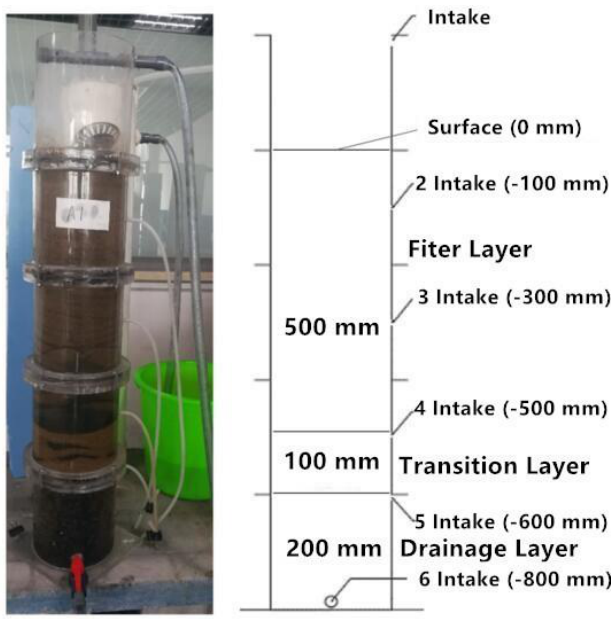
Figure 2. Schematic of bioretention units for water quality performance experiments.